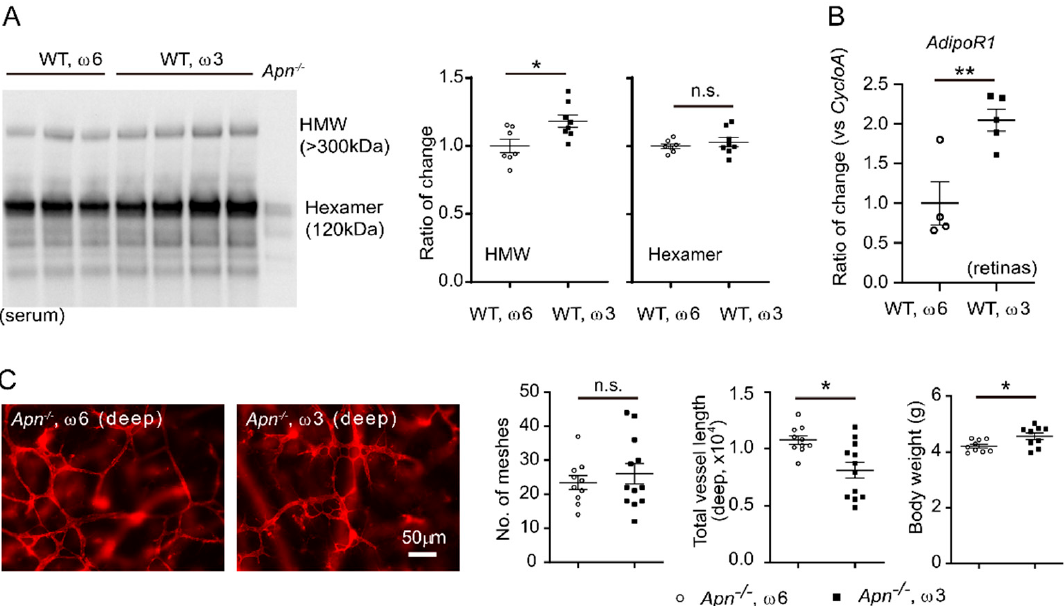
Figure 8. APN mediated ω -3-LCPUFA promotion on retinal vessel growth in Phase I ROP. ( A ) ω - 3 versus ω -6 LCPUFA-enriched diet increased serum HMW APN levels. A total of 1 μ L serum was used for Western Blot. n = 7–8 mice per group. Unpaired t -test. * p < 0.05, n.s., no significance. Data are represented as mean ± SEM. ( B ) ω -3 versus ω -6 LCPUFA-enriched diet increased retinal AdipoR1 expression. n = 4–5 mice per group. Unpaired t -test. ** p < 0.01. Data are represented as mean ± SEM. ( C ) APN deficiency partially abolished ω -3 vs. ω -6 LCPUFA promotion of retinal vessel growth.